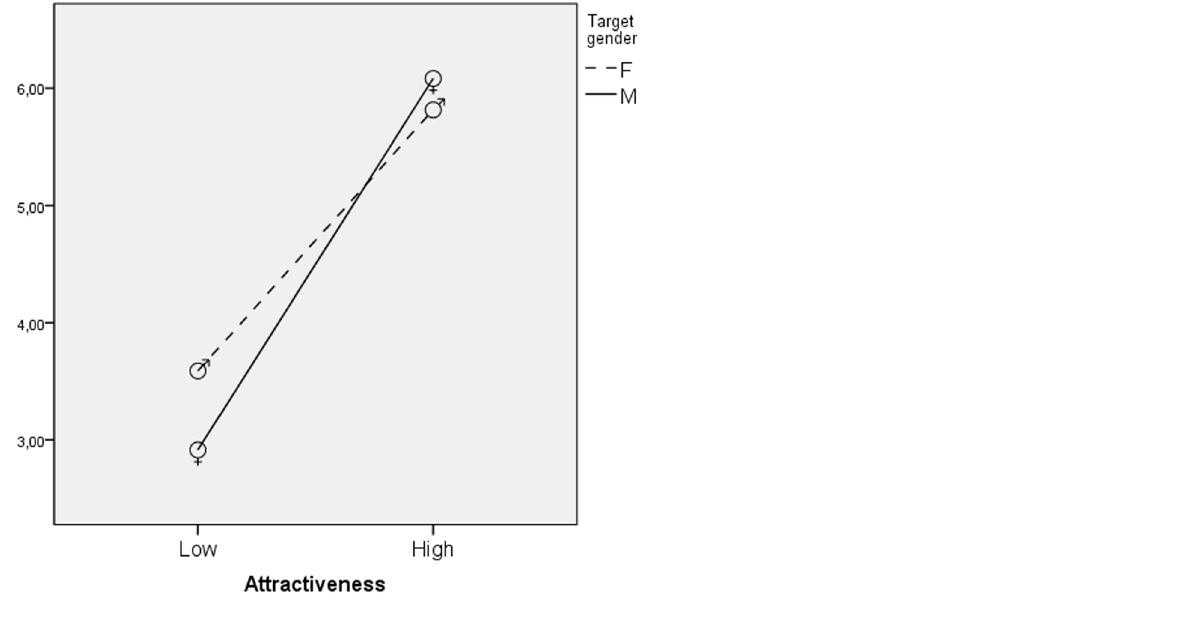
Figure 1. Interaction of attractiveness and target gender: Evaluation of the target in terms of extraversion mean scores.